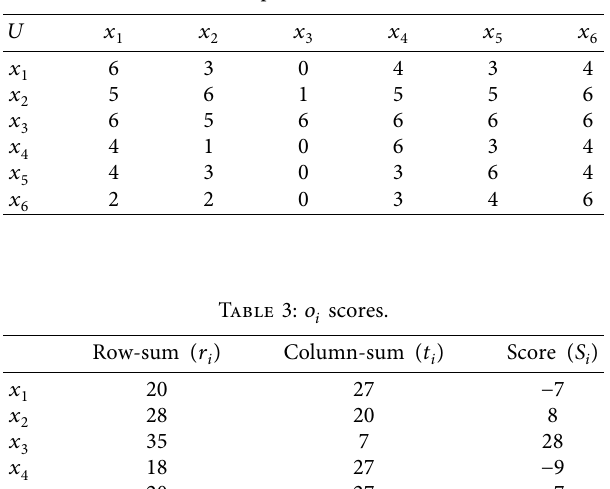
Table 2: Comparison table of ( H,E ) .